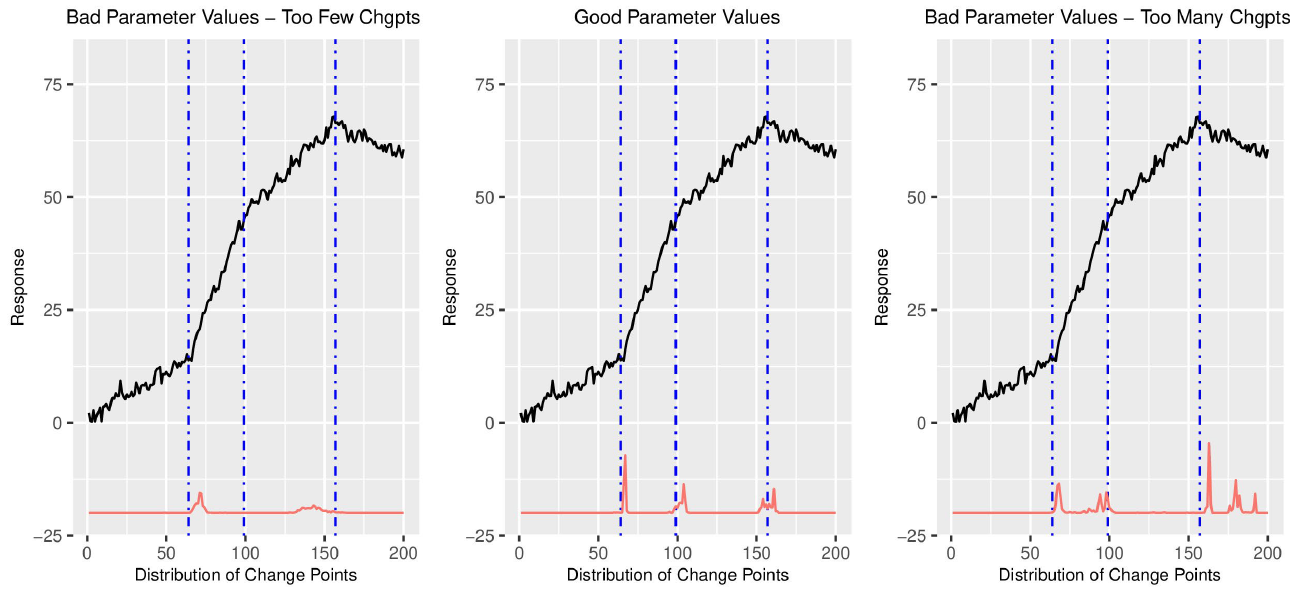
Figure 2. “Good” and “Bad” Parameter Choices. A representative dataset using the data generation process described in Section 3.1 is analyzed using different sets of values for the hyperparameters. Dotted vertical lines indicate the actual location of the change points. The left panel uses a set of parameters that produces a posterior distribution which infers too few change points while the right panel uses a set of parameters that produces a posterior distribution that infers too many change points. The middle panel correctly identifies the correct number of change points.